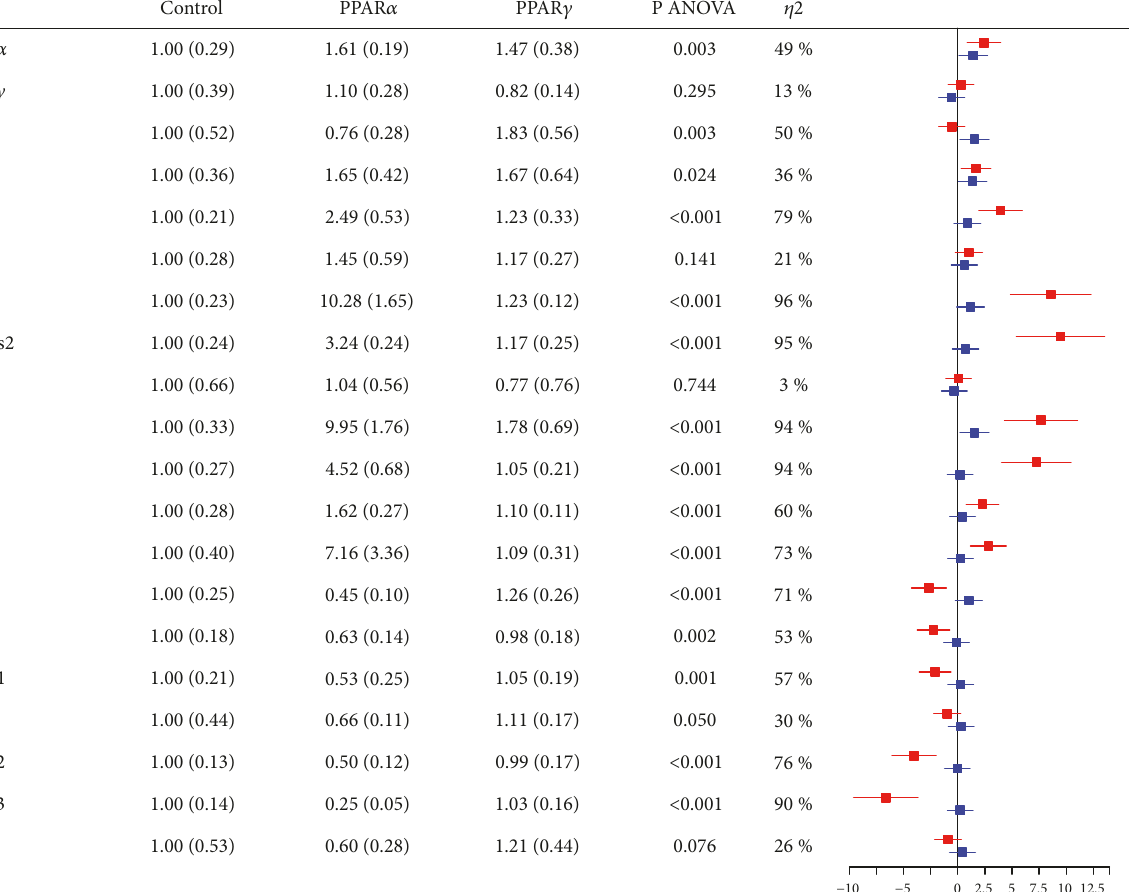
Figure 4: Hepatic gene expression in Wistar rats after treatment with PPAR agonists for 12 days, normalized towards the control group. Red barscorrespondtoPPAR 𝛼 vscontrolandbluebarstoPPAR 𝛾 vscontrol.Acox1,fattyacyl-CoAoxidase1;ANOVA,analysisofvariance;ApoA1, apolipoprotein A1; ApoB, apolipoprotein B; ApoC2, apolipoprotein C2; ApoC3, apolipoprotein C3; Cd36, cluster of differentiation 36; Cpt1a, carnitine palmitoyltransferase 1a; Cpt2, carnitine palmitoyltransferase 2; Fabp1, fatty acid binding protein 1; Fas, fatty acid synthase; Fatp1, fatty acid transport protein 1; Hmgcs2, 3-hydroxy-3-methylglutaryl-CoA synthase 2; Lipc, hepatic lipase C; Lpl, lipoprotein lipase; Pgc1 𝛼 , peroxisome proliferator-activated receptor › coactivator 1 𝛼 ; Pltp, phospholipid transfer protein; Ppar 𝛼 , peroxisome proliferator-activated receptor 𝛼 ; Ppar › , peroxisome proliferator-activated receptor › ; TNFa, tumor necrosis factor alpha; Ucp2, uncoupling protein 2.